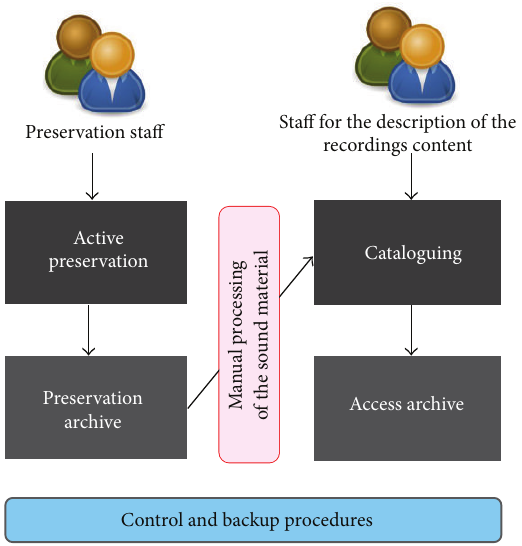
Figure 7: High-level schematization of the preservation workflow from the viewpoint of the software